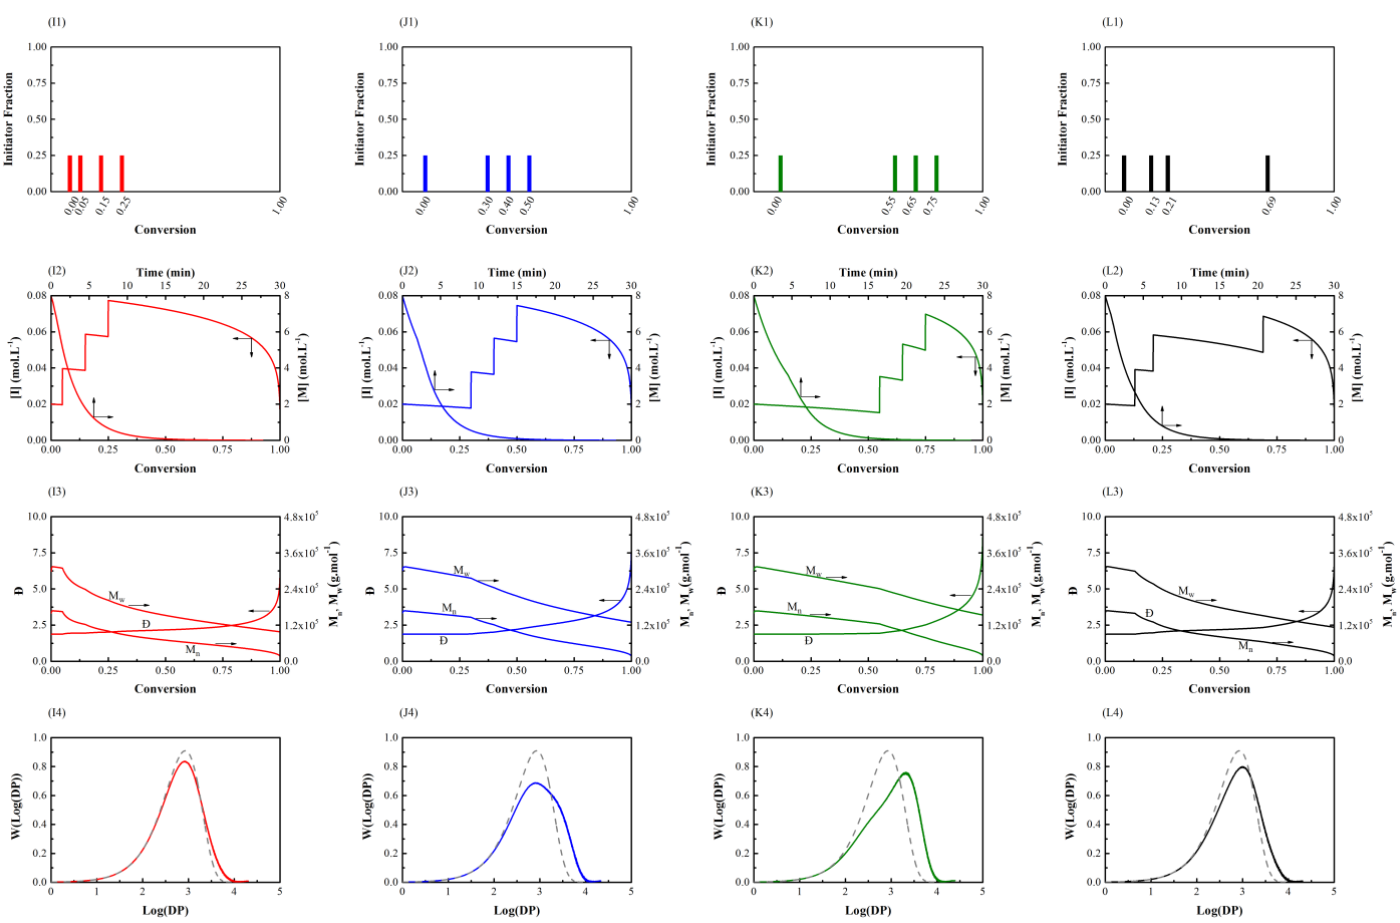
= 8.00 mol L –1 and [ I ] = 0.08 mol L –1 . 13 0 0